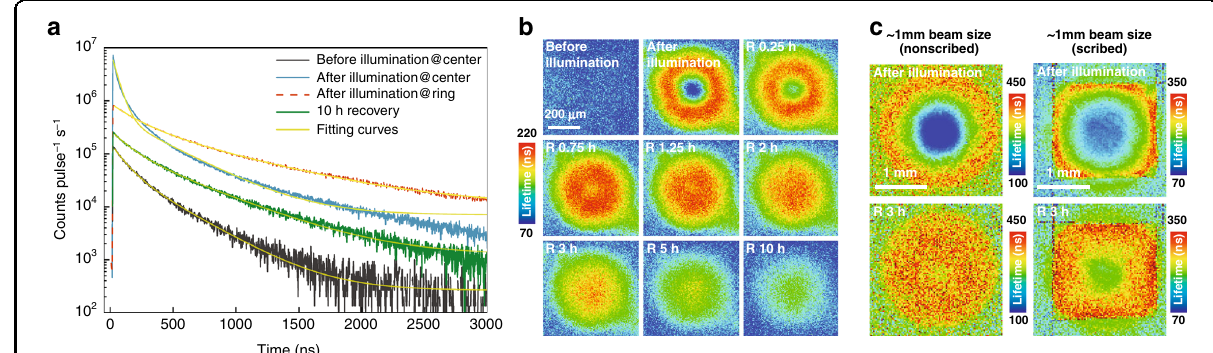
Fig. 4 The dynamics of the ion redistribution probed by TRPL. a PL decay traces at different illumination states. b TRPL mapping before and after local illumination and during the recovery process. c TRPL mapping after local illumination in a non-scribed and scribed